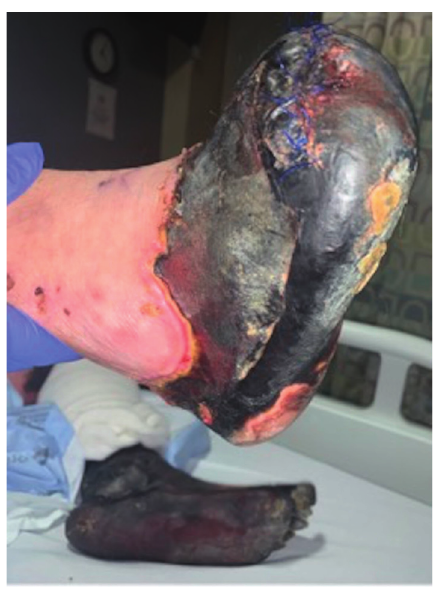
Figure 4: Bilateral gangrenous lower extremities 10 days after initial